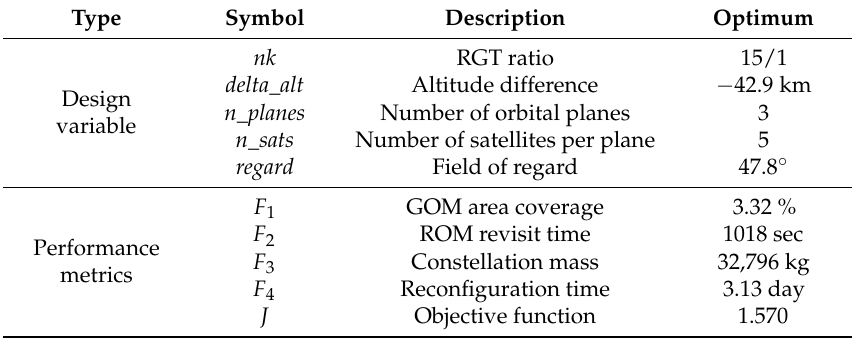
Table 13. SA optimal solution (3 planes).